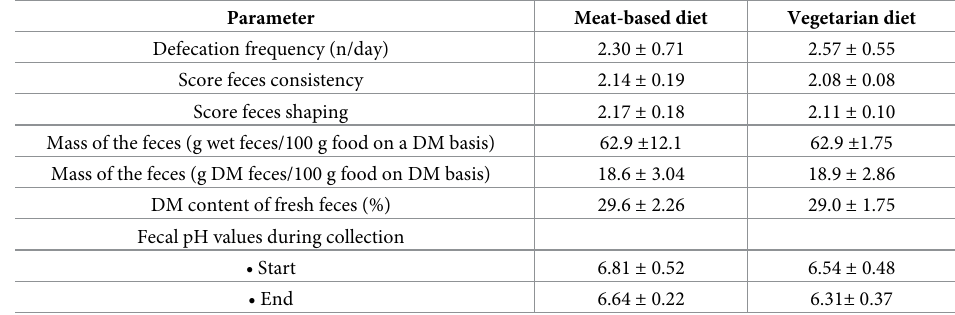
Table 5. Fecal characteristics of dogs fed experimental diets (mean ±